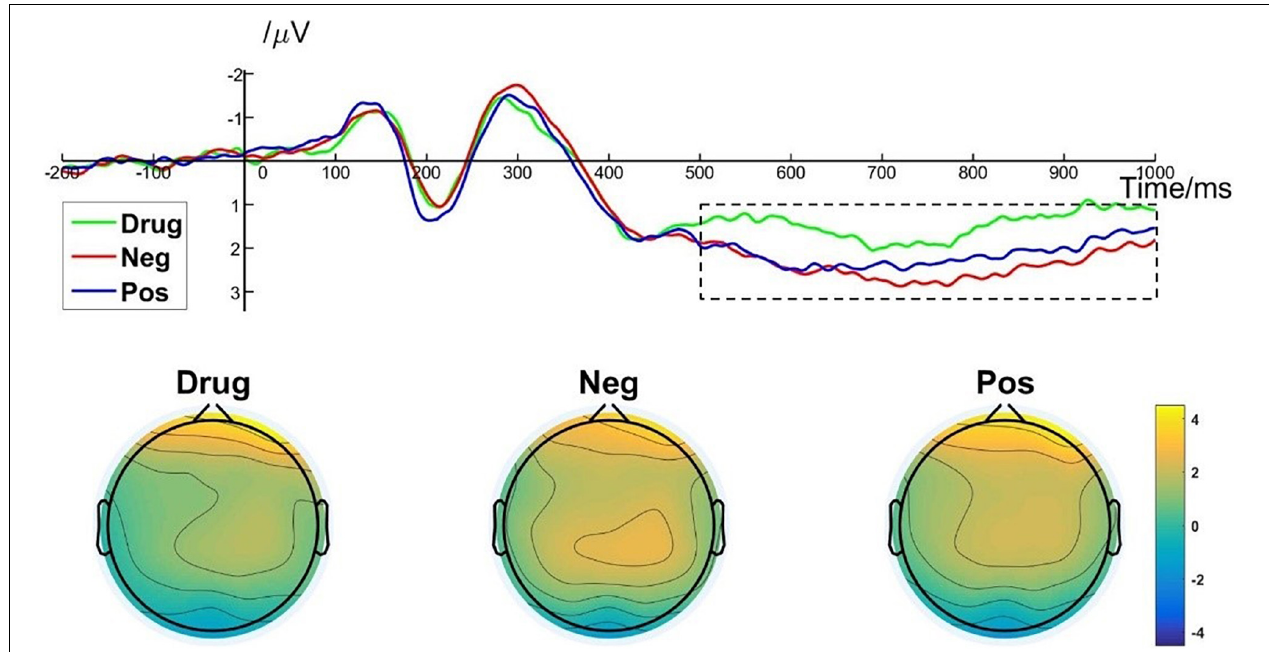
FIGURE 6 | LPP component elicited under different conditions at electrode sites Cz, CPz, and brain topography of